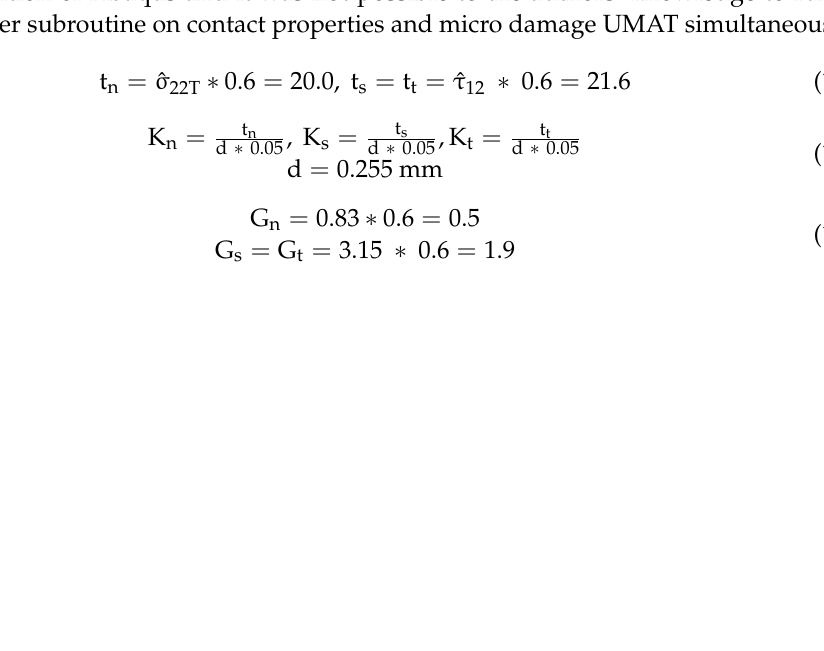
Figure 8. S-N curve for the matrix shear plotted against the reduction factor on the delamination properties. See the Material Properties section for further information on the S-N curve.